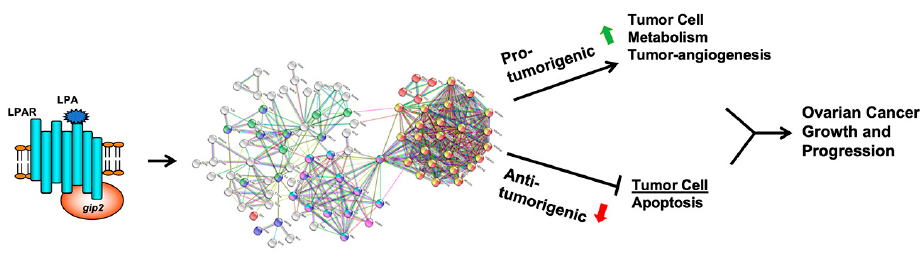
Figure 5. Gip2-regulated onco-transcriptome in ovarian cancer. LPA-LPAR-stimulation or mutational activation of gip2 drove the coordinated regulation of two major network clusters. Gip2-stimulated pro-tumorigenic network comprised of nodes involved in tumor cell metabolism and angiogenesis synergizes with the suppression of anti-tumorigenic network consisting of pro-apoptotic and growth-suppressive nodes. LPA; lysophosphatidic acid; LPAR, lysophosphatidic acid receptor; gip2 , G protein subunit α i2. depicted here is derived from the data using a single ovarian cancer cell line. Nevertheless,